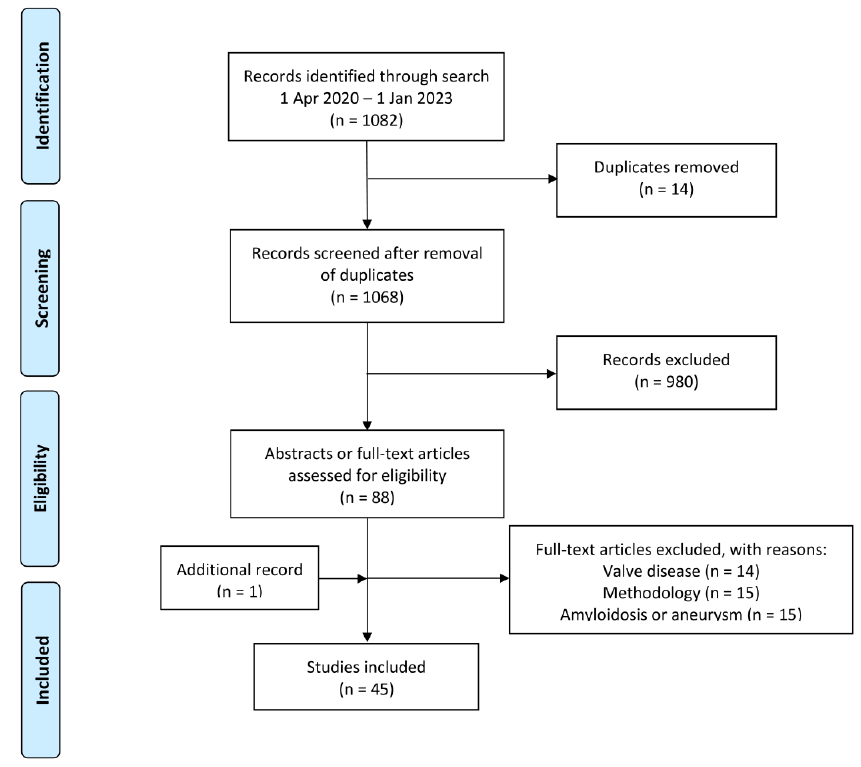
Figure 1. PRISMA Flow Diagram .